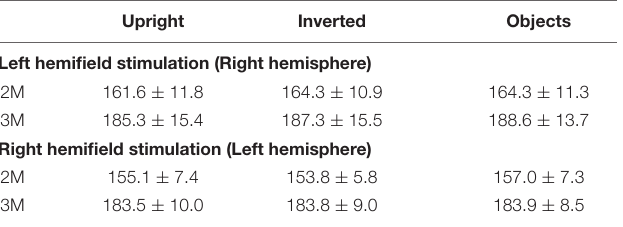
SD, standard deviation.